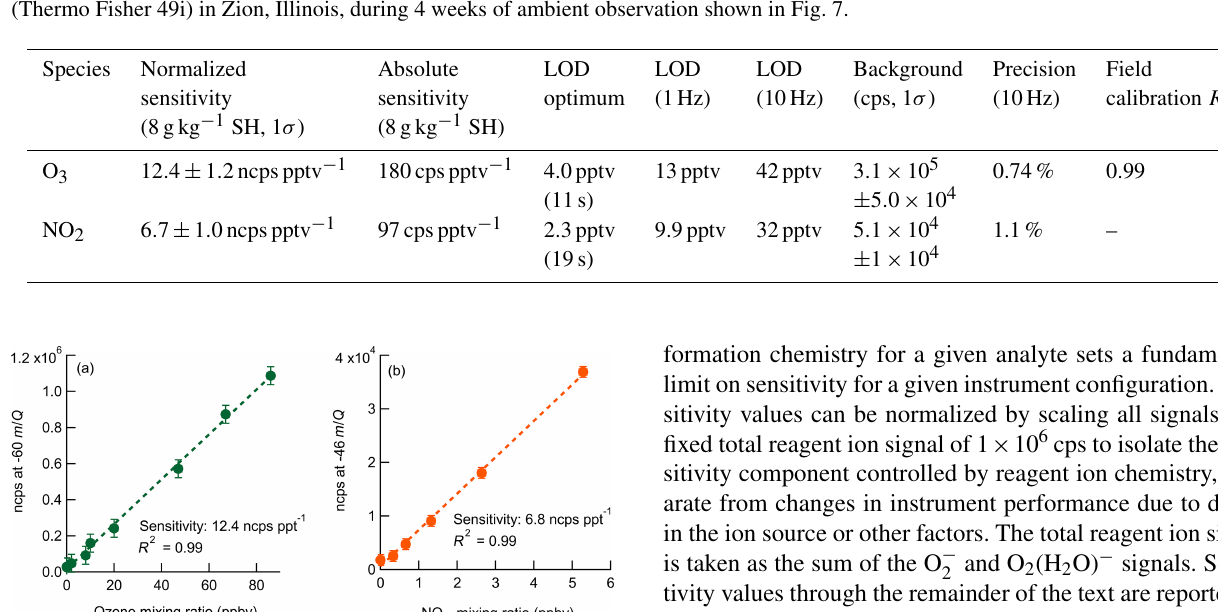
Table 1. Summary of instrument sensitivity, precision, and accuracy for detection of O 3 and NO 2 from laboratory calibrations. Sensitivity is reported at a specific humidity (SH) of 8gkg − 1 which corresponds to 40% RH at 25 ◦ C. All limits of detection (LODs) are for a signal-to- noise ratio (S/N) of 3. The optimum LOD is reported as the LOD at the optimum averaging time determined by the minimum of the Allan variance spectrum. Optimum averaging times were determined to be 11s for O 3 and 19s for NO 2 . The reported field comparison ( R 2 ) is from a regression of 1min bin averaged ozone concentration from the Ox-CIMS with an EPA (Environmental Protection Agency) monitor (Thermo Fisher 49i) in Zion, Illinois, during 4 weeks of ambient observation shown in Fig. 7.